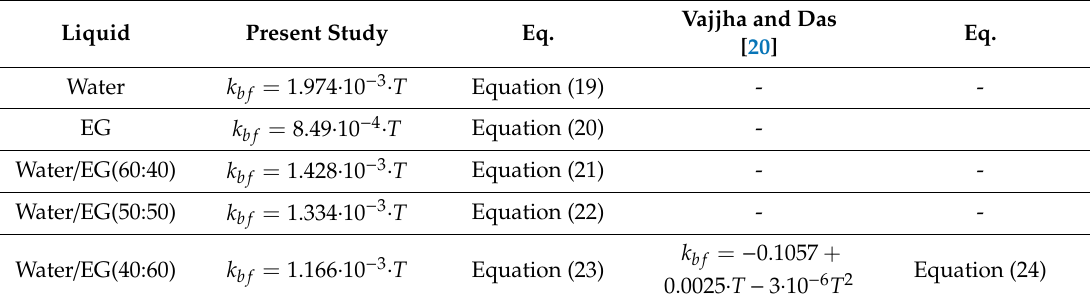
Table 4. Correlations for the thermal conductivity of the base